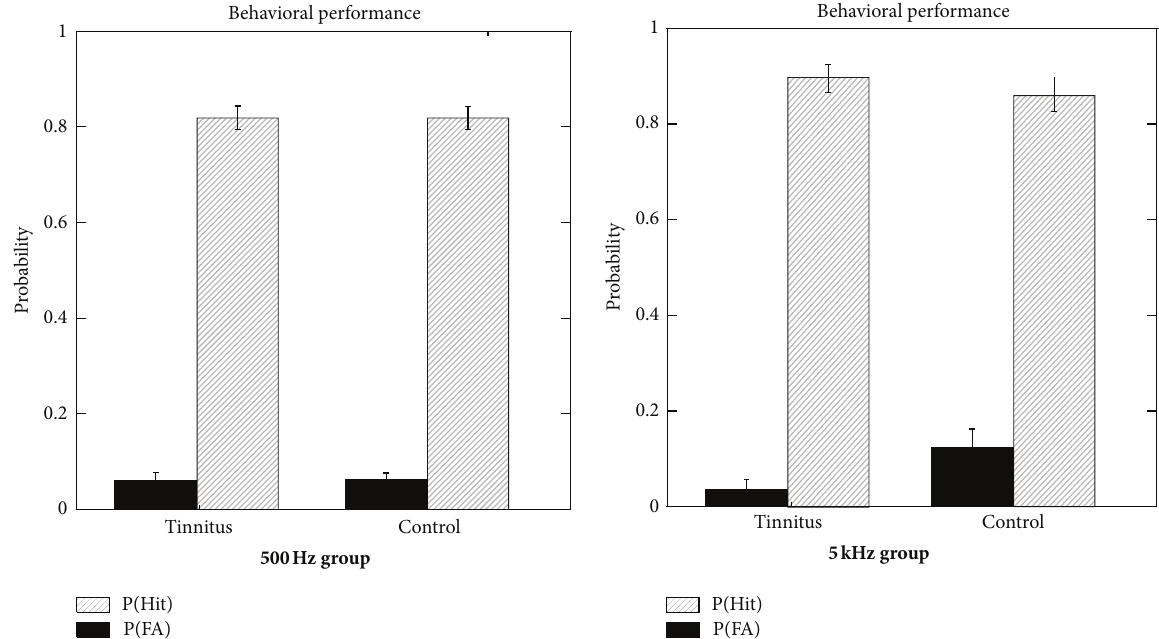
Figure 4: Performance on the behavioral task for both tinnitus and control groups probed at 500 and 5kHz. The probability of a hit ( 𝑃 (Hit)) is averaged across the six target amplitude enhancements. The probability of a false alarm ( 𝑃 (FA)) was determined from trials with no target.